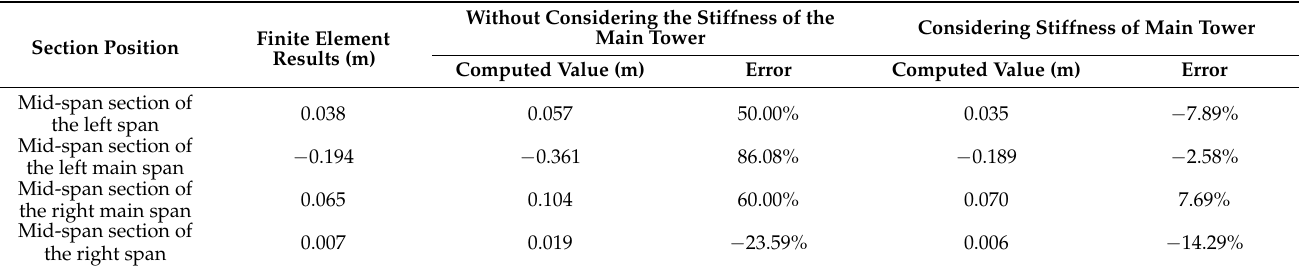
Table 1. The deformation of control section of stiffening beam under live load in the middle section of left main span.